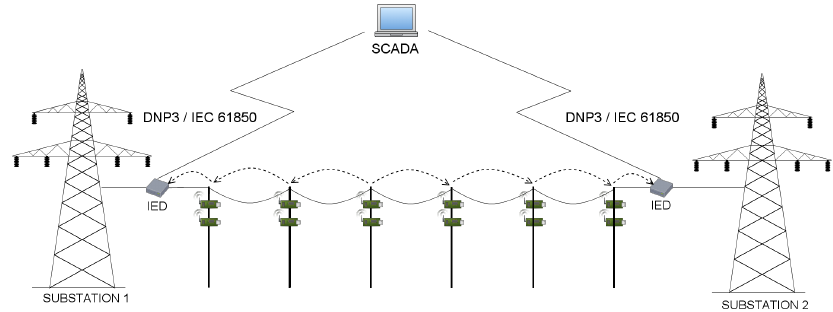
Figure 2. A typical transmission grid